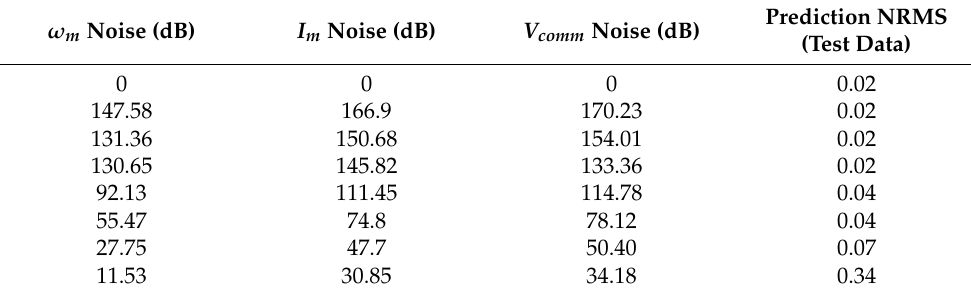
Table 7. Model performance degradation for different noise